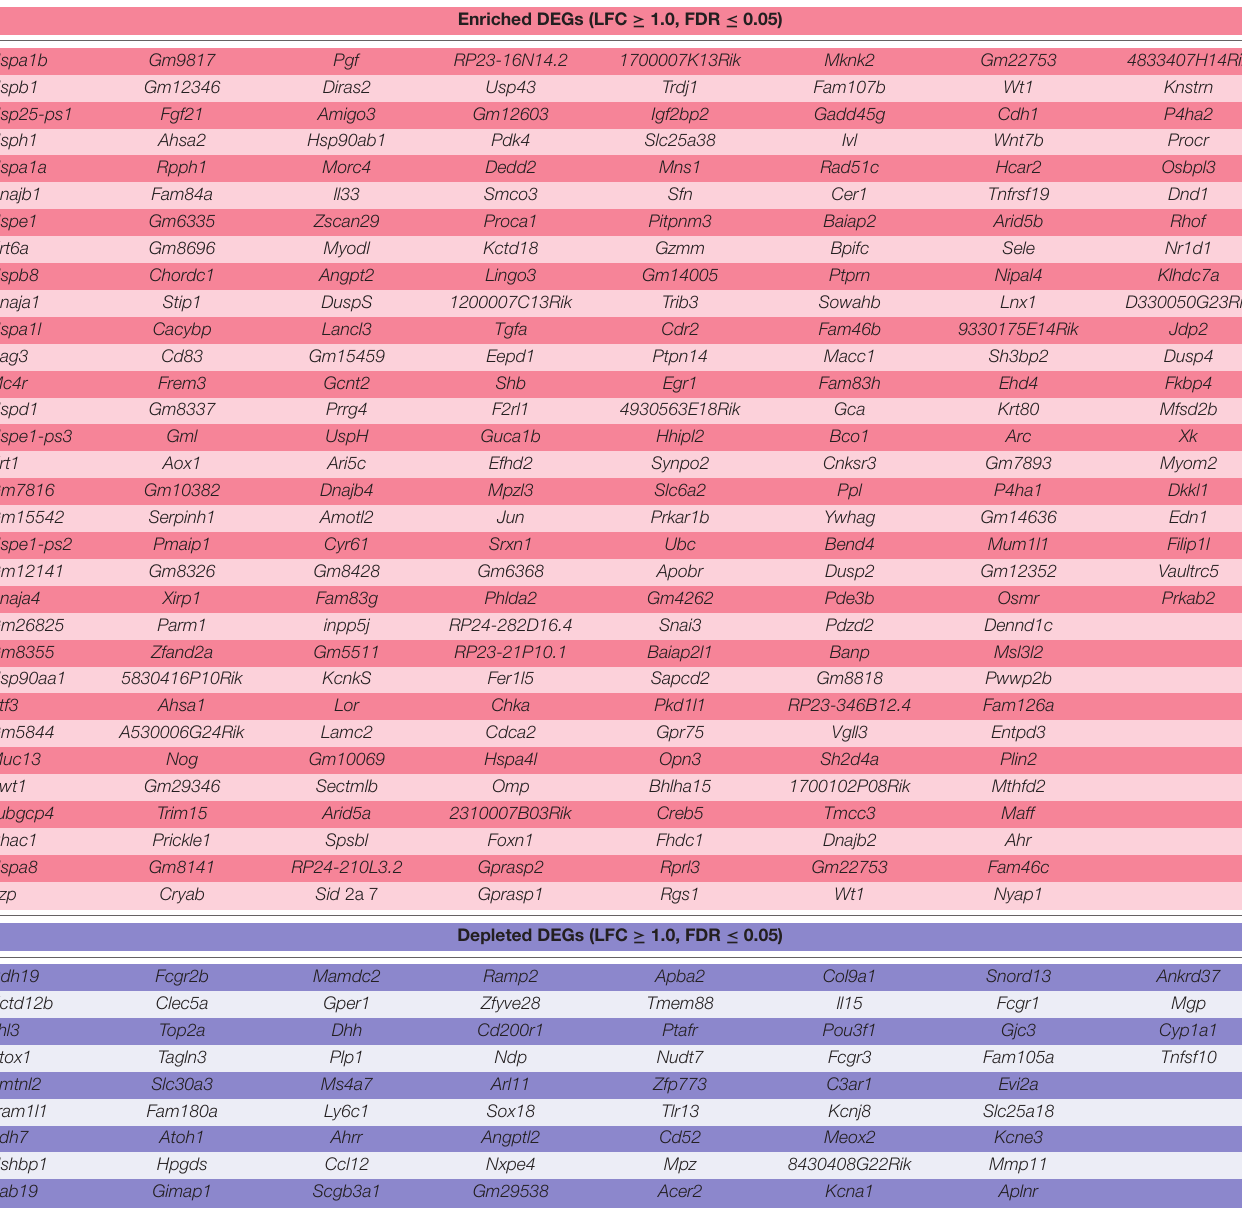
TABLE 3 | DEG analyses produce a transcriptional signature of genes that are enriched or depleted by heat